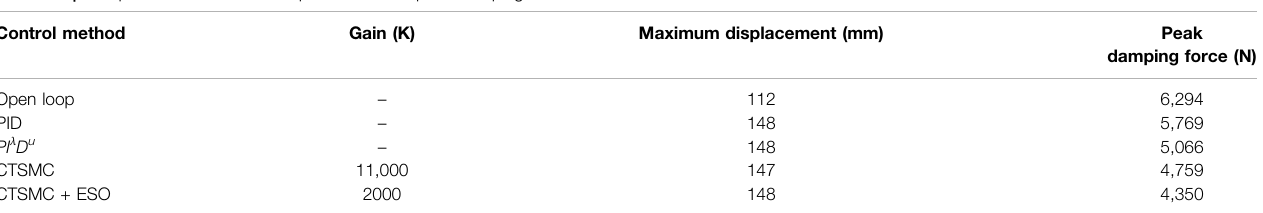
TABLE 1 | Comparison of maximum displacement and peak damping force of fi ve control